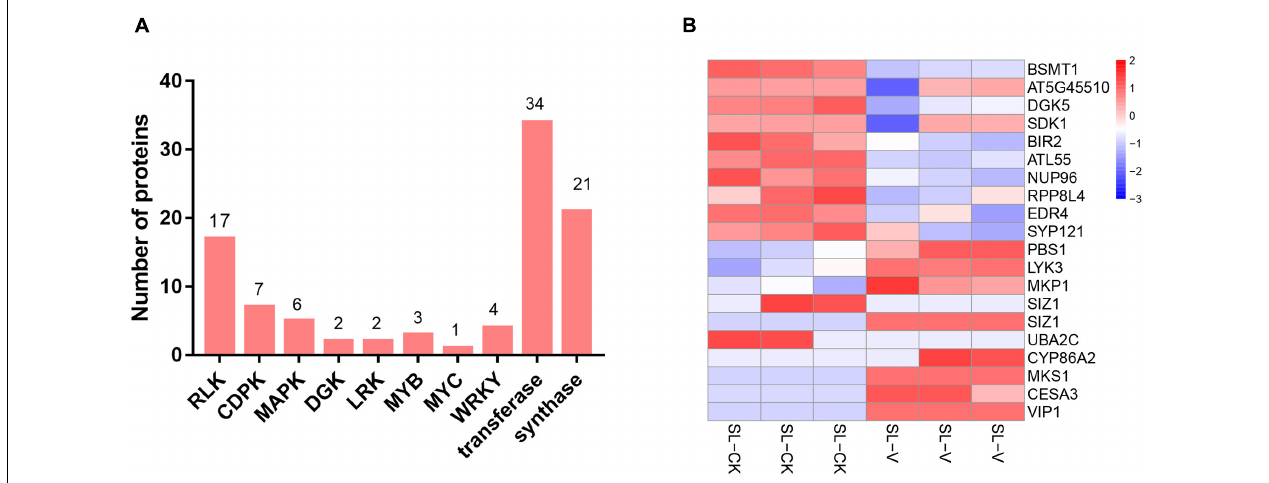
FIGURE 6 | Overview of significantly changed kinases, TFs, transferases, synthases, and defense response-related proteins identified in phosphoproteome. (A) Numbers of significantly changed kinases, TFs, transferases, and synthases. (B) Heat map of significantly changed defense response-related phosphopeptides from systemic leaves of Psm ES4326 and mock locally inoculated plants. Data were normalized based on Z-score, and hierarchical analysis was performed by bottom-up clustering method using Euclidean distance. V, virulent Psm ES4326; CK, 10 mM MgCl 2 ; SL-V, systemic leaves of Psm ES4326 locally inoculated plants; SL-CK, systemic leaves of MgCl 2 locally inoculated